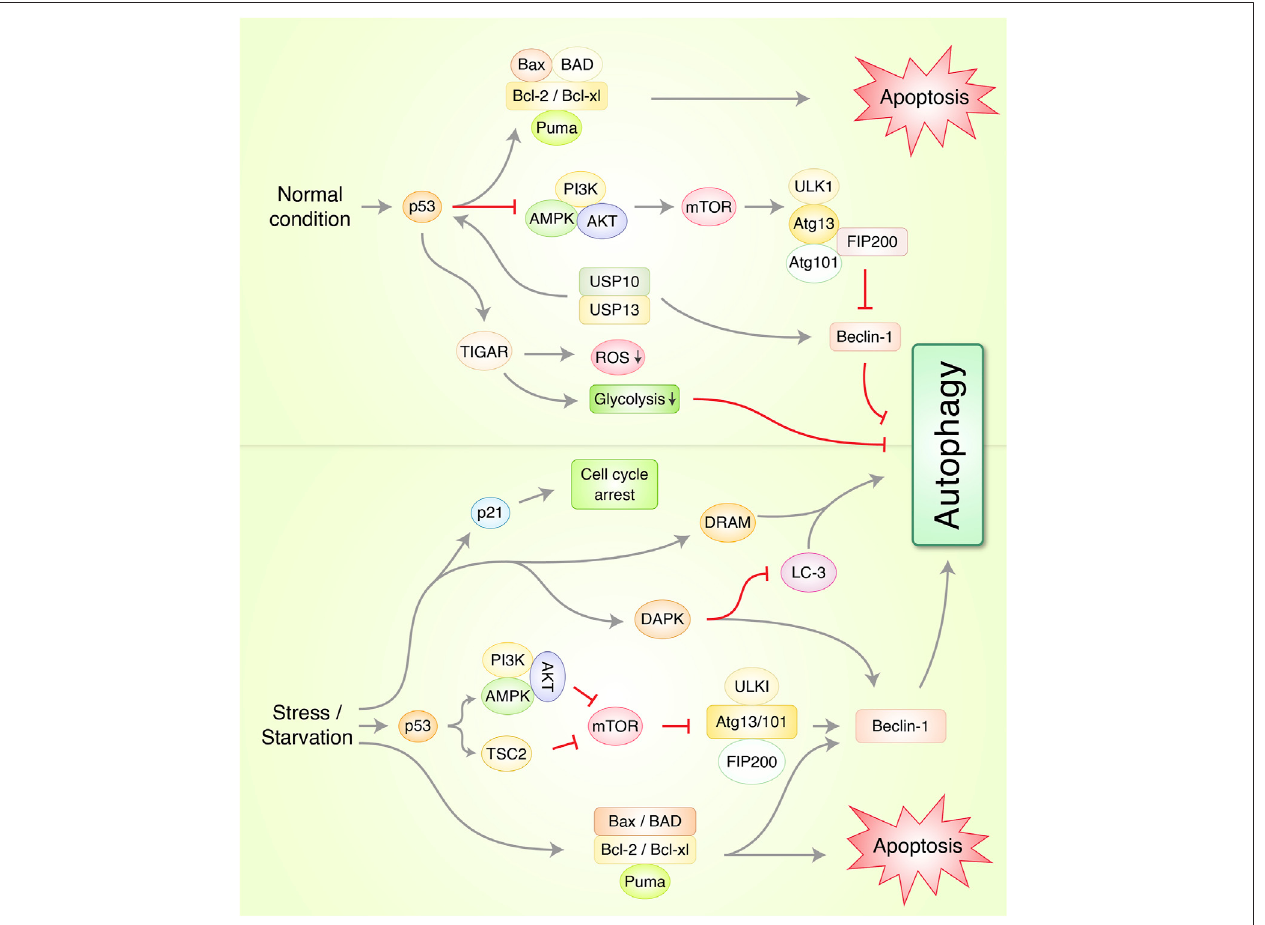
FIGURE 3 | Molecular mechanism of autophagy and apoptosis via p53 regulation in cancer under normal and stress conditions. In normal condition, p53 protein prevents autophagy-mediated cell death via induction of Beclin-1 degradation through ubiquitin-speci fi c peptidases USP10/USP13 and AMPK/mTOR/ULK1 complex activation. TP53-induced glycolysis and apoptosis regulator (TIGAR) prevents autophagy through suppression of reactive oxygen species (ROS) and glycolysis formation. Under stress/starvation condition, p53 activates AMPK and tuberous sclerosiscomplex 2(TSC2) which suppresses mTOR and ULK1/FIP200 complex which fi nally stimulates autophagy. Cyclin-dependent kinase inhibitor 1, p21, activates and arrests cell cycle via p53-mediated upregulation. Additionally, death- associated protein kinase (DAPK), and damage-regulated autophagy modulator (DRAM), autophagy-related protein Beclin-1 upregulation initiates autophagy. Bcl-2 family, Bcl-2, Bcl-xl, Bax, Bad, and PUMA activates apoptosis.